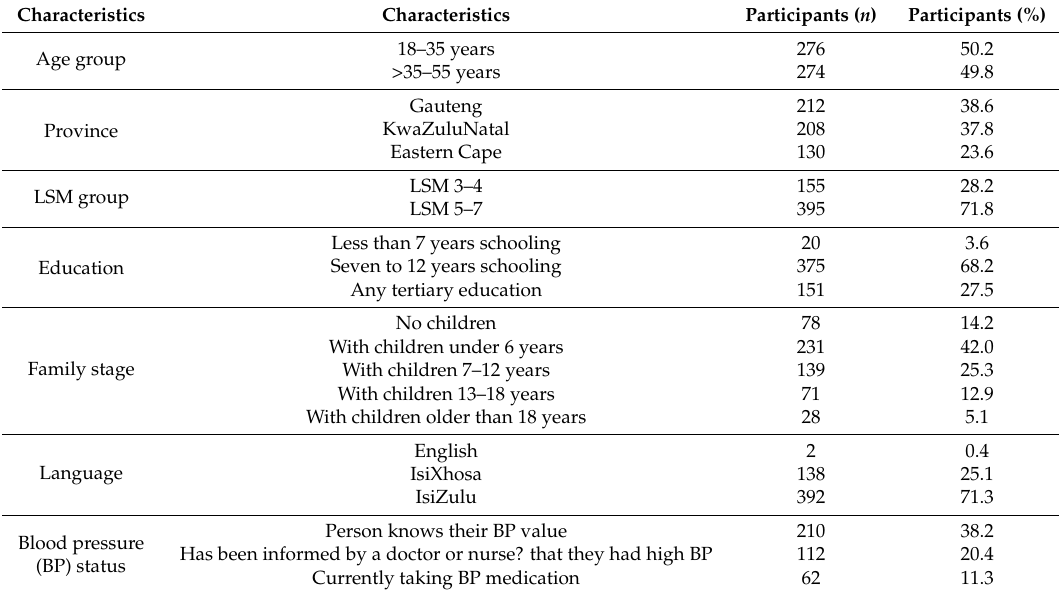
Table 2. Characteristics of participants in the baseline survey ( n =